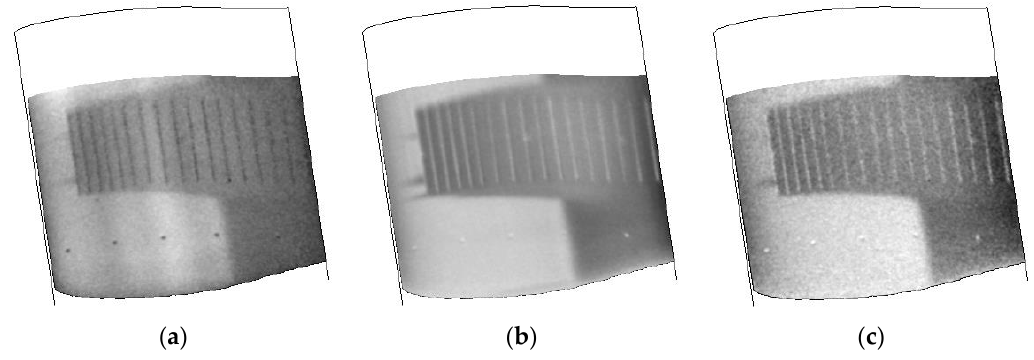
Figure 14. Effect of the method for introduction of the temperature step. Data were collected at T = 200 K, Mach 0.7, Re = 32.8 M/m: ( a ) CNT heater; ( b ) fast injection; and ( c ) slow injection.